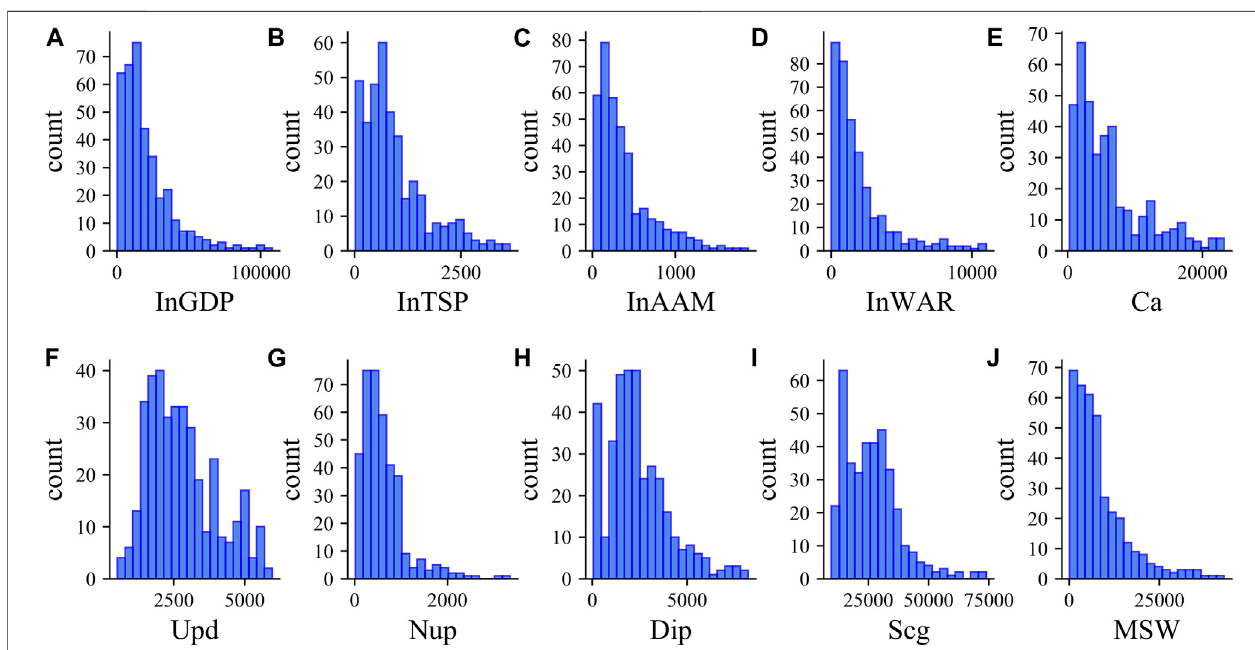
FIGURE3| Histogram plotsforthedifferentinputsand output variables usedtotraintheMLmethods. (A) is InGDP , (B) is InTSP , (C) is InAAM , (D) is InWAR , (E) is Ca , (F) is Upd , (G) is Nup , (H) is Dip , (I) is Scg , (J) is MSW .